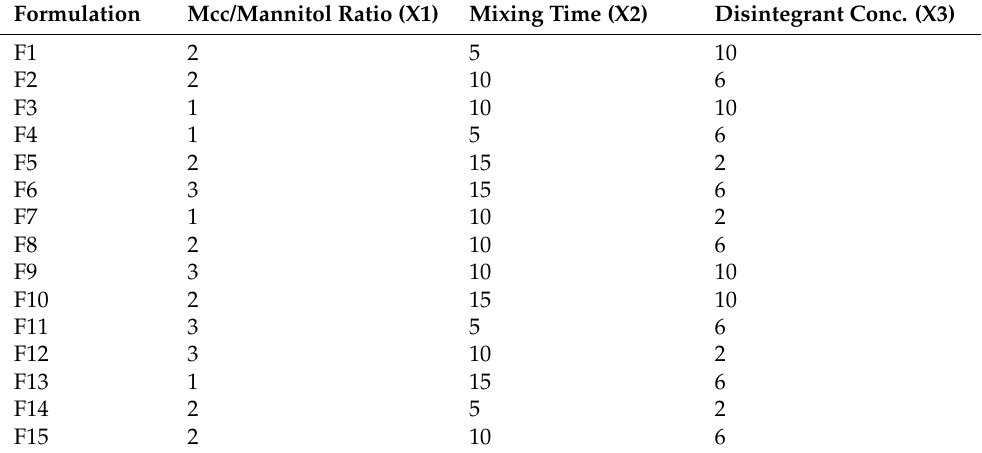
Table 9. Matrix of formulations in Box–Behnken design for Lornoxicam